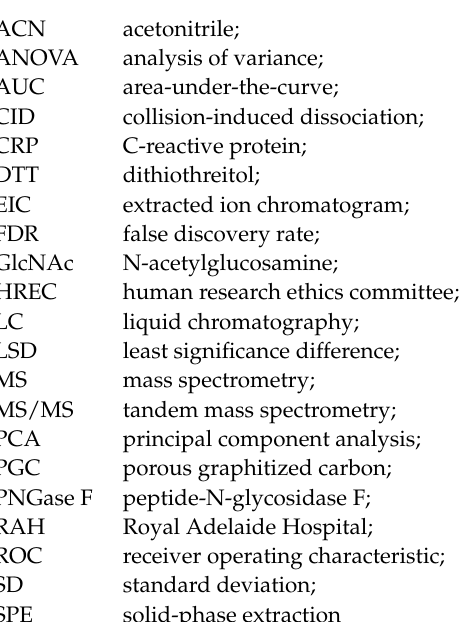
Supplementary Table S3: Quantitation of the N -glycan classes and structural